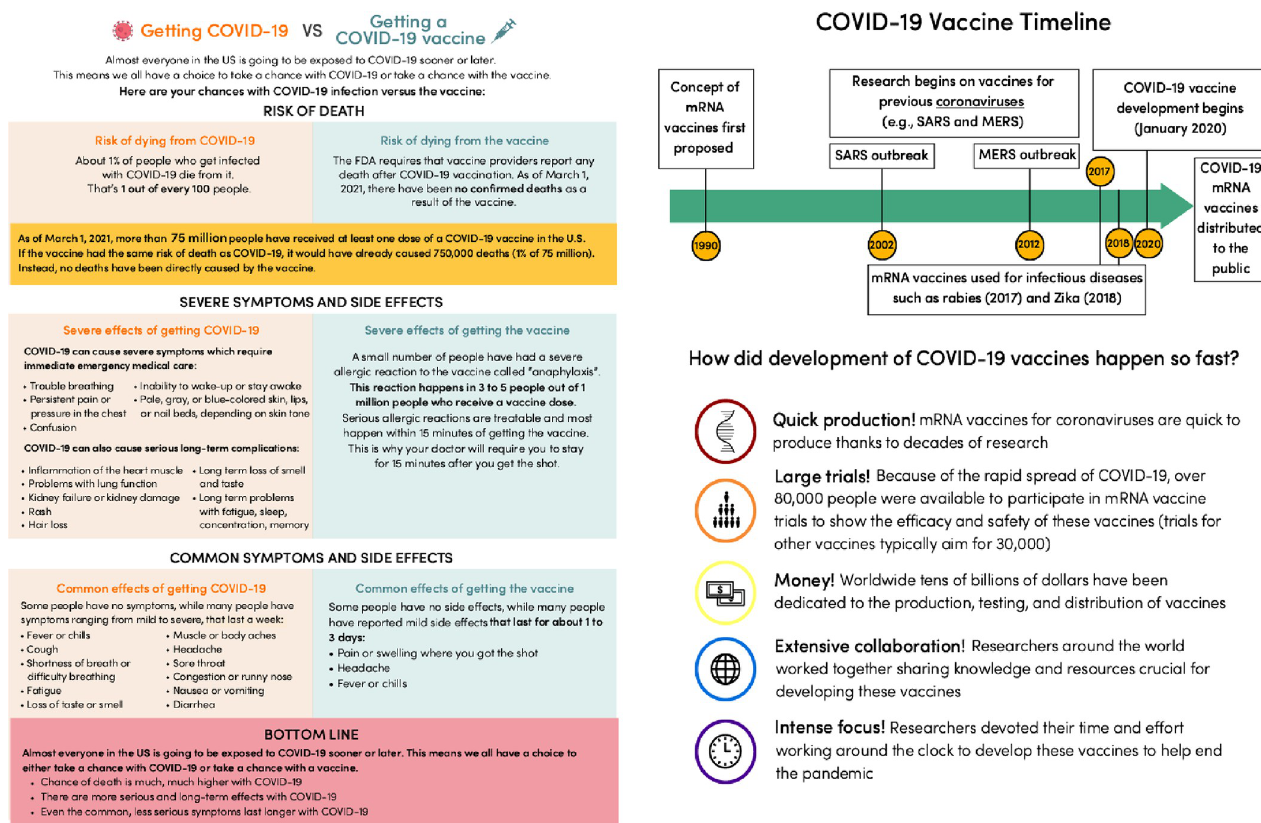
Fig 1. Factbox style message (left) about the risks of getting a vaccine compared to getting COVID-19 and the Timeline message (right) about the development of COVID-19 vaccines.